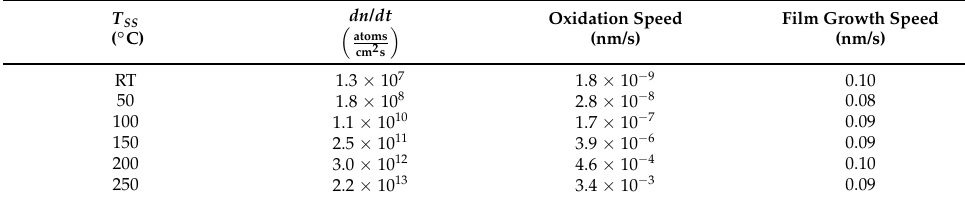
Table 3. Comparison of oxidation speed to film